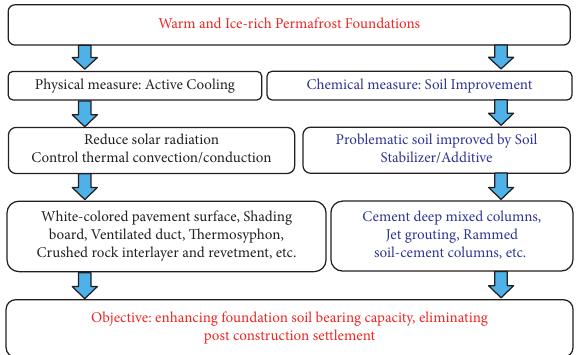
Figure 5: Category of frozen soil